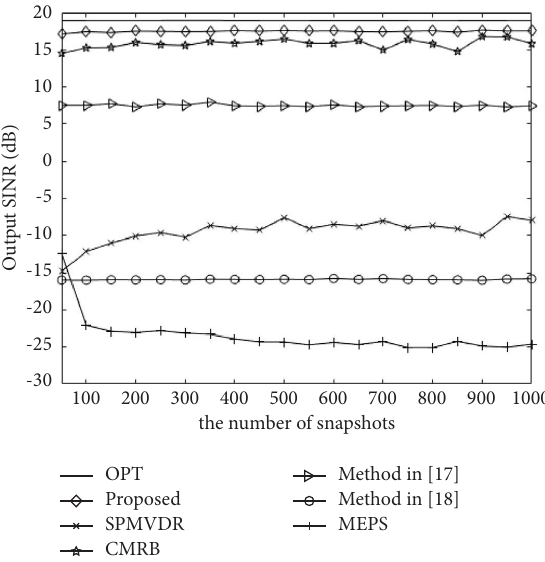
Figure 5: Output SINR versus the number of snapshots with a parameter error of the desired signal.